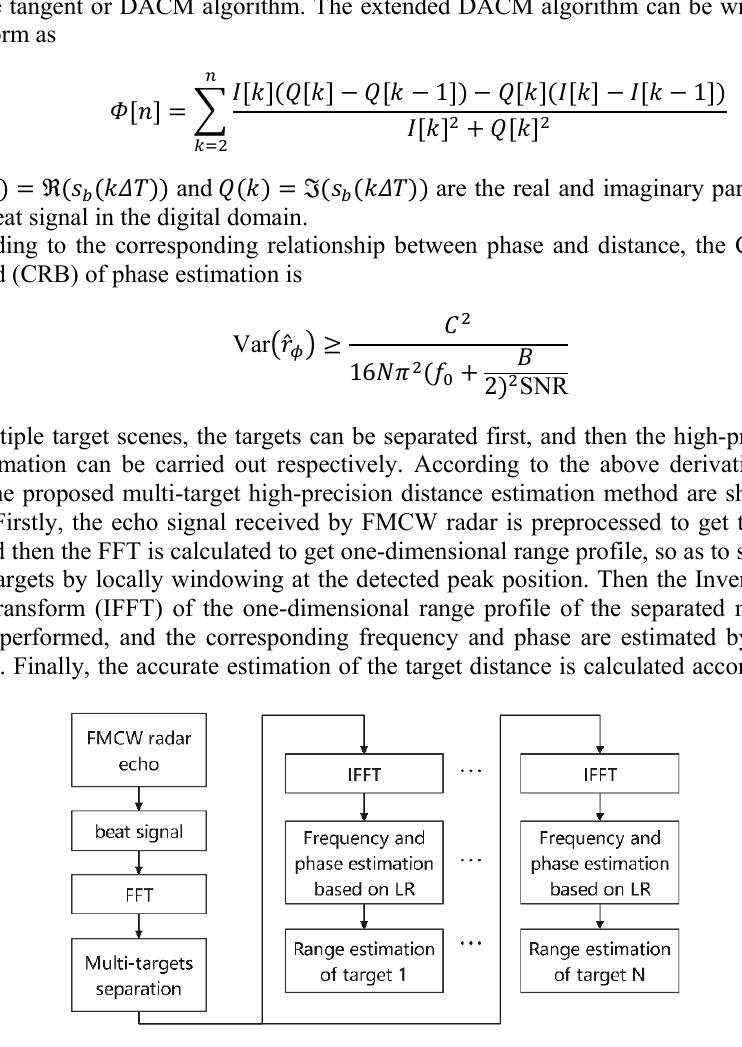
Fig. 1. Processing steps of the proposed multi-target high-precision range estimation